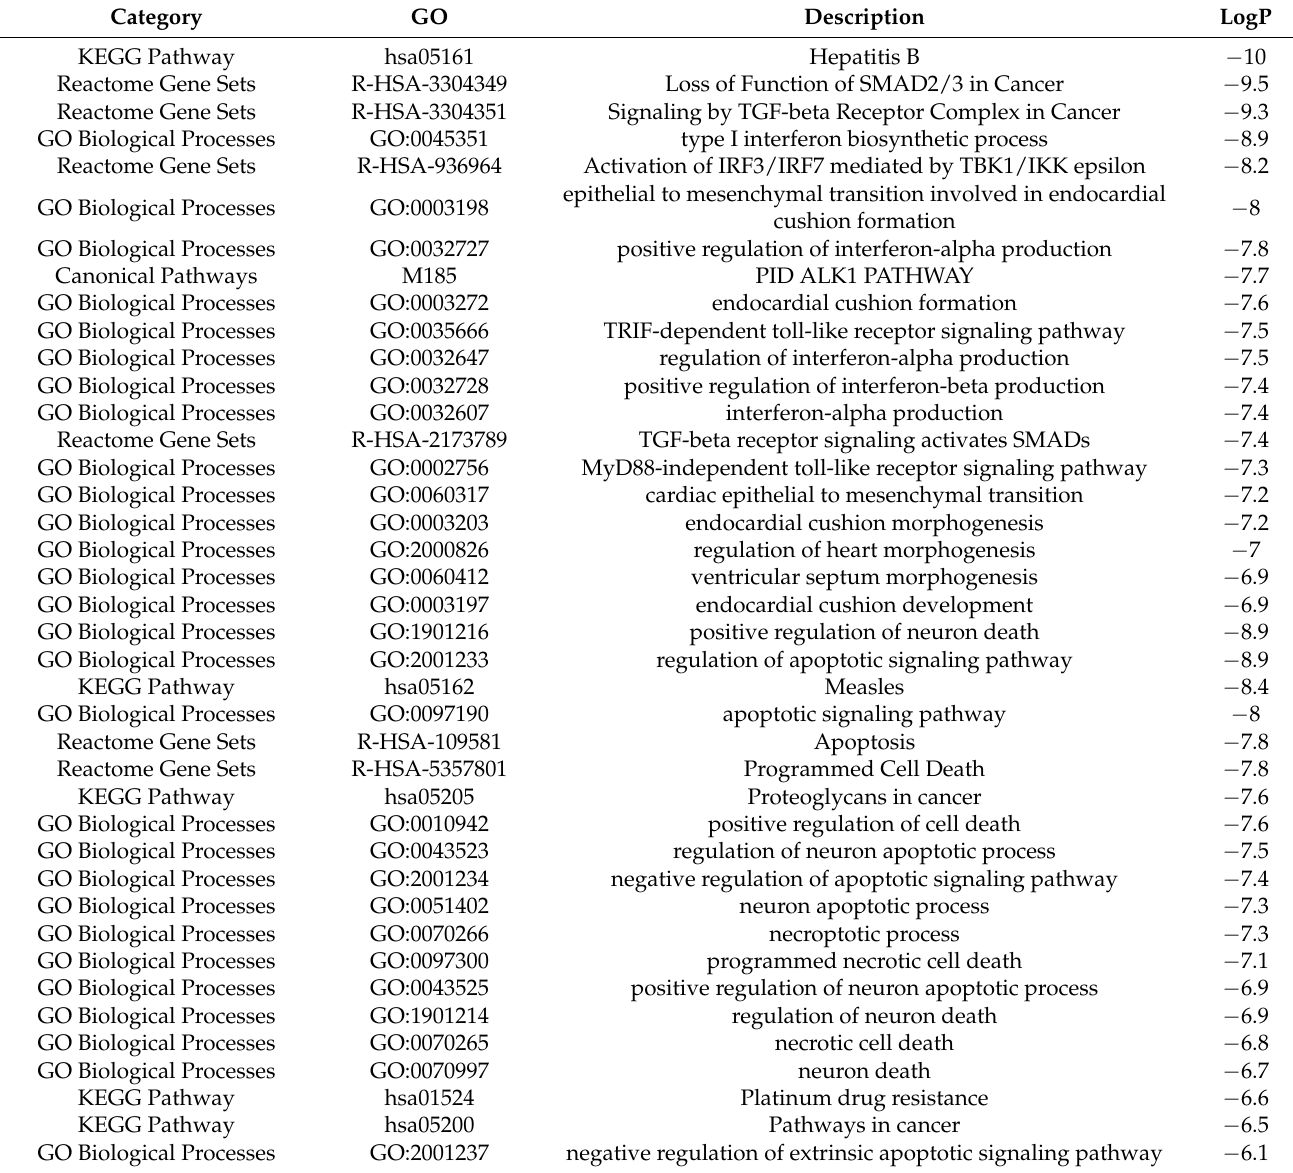
Table 1. The significant genes enriched in the different pathways. In red are the enriched pathways for the network in Figure 3A; in blue is the sub-network in Figure